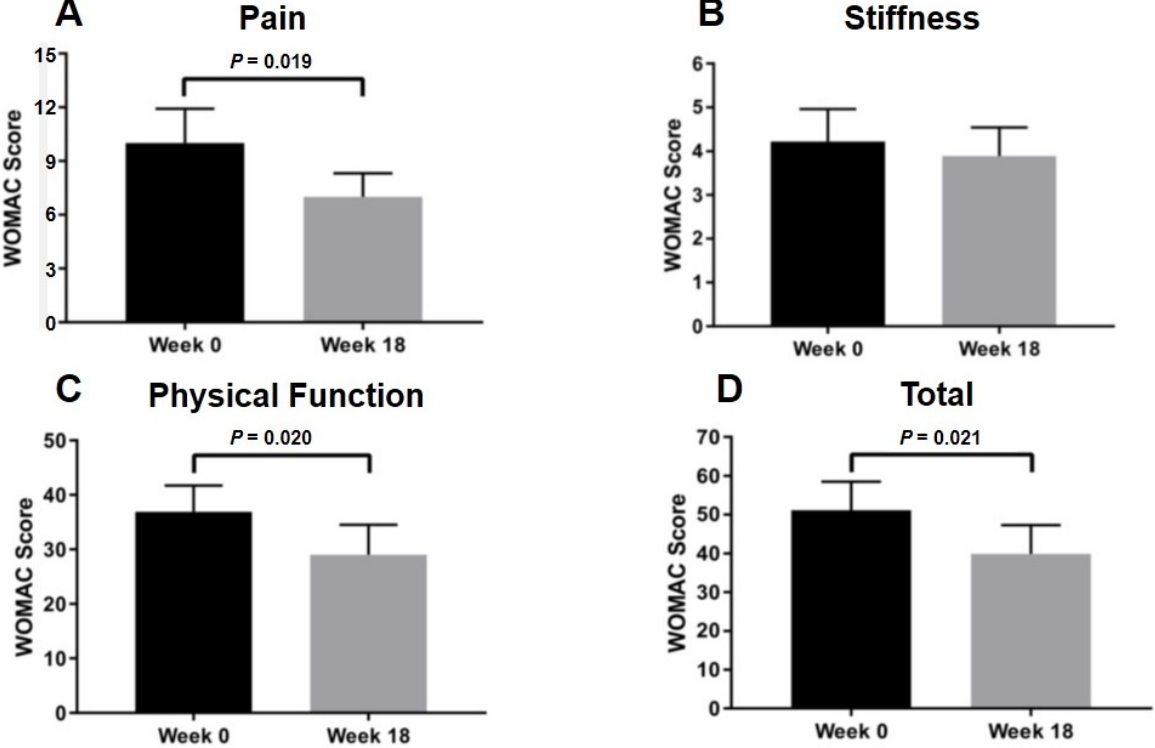
Figure 5. Comparison of WOMAC score at 0 and 18 weeks following intra-articular PRP injection in knee OA patients: ( A ) pain; ( B ) stiffness; ( C ) physical function; ( D ) total score. Abbreviations: WOMAC, Western Ontario and McMaster Universities Osteoarthritis.